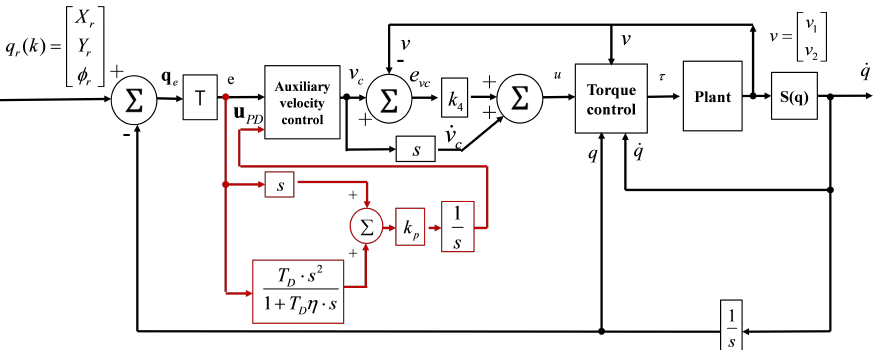
Figure 6. A control scheme of PD-backstepping for the trajectory tracking controller.